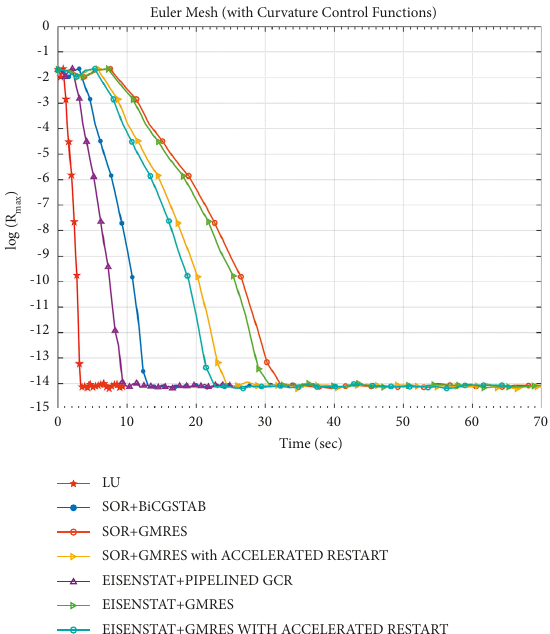
Figure 16: Convergence for the Euler mesh vs. time, with curvature